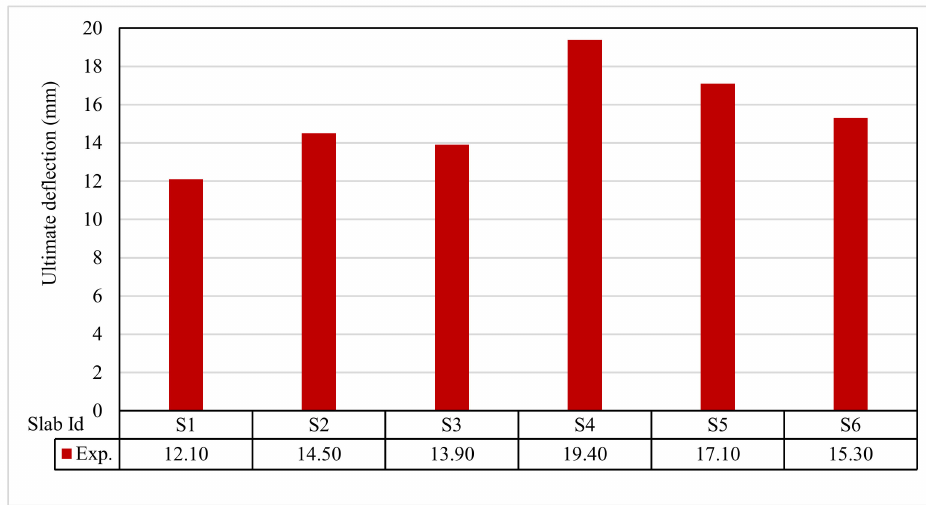
Figure 14. Ultimate defection for tested